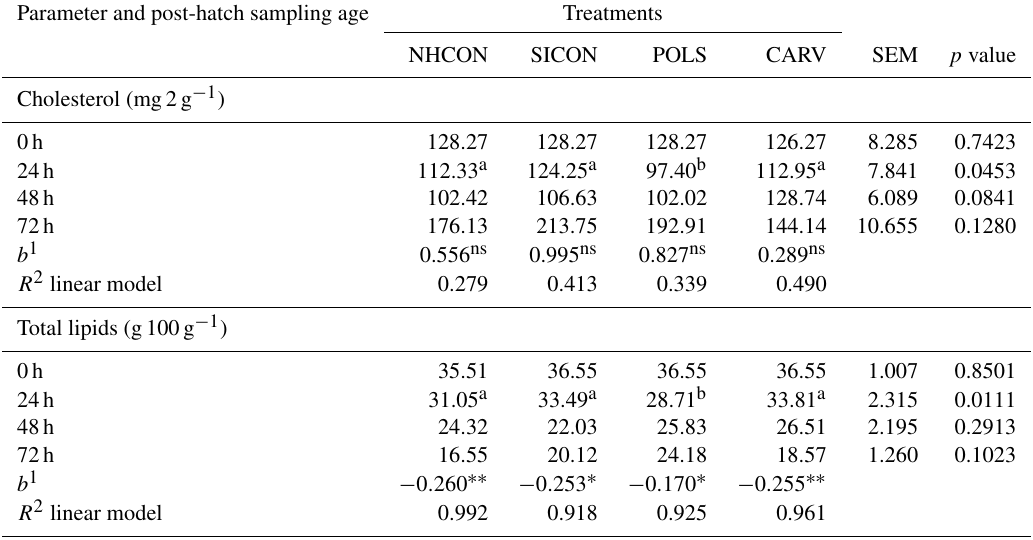
Table 1. Total cholesterol and total lipids concentration in yolk sac in the chicks subjected to experimental treatments, namely non-handled control (NHCON), sham injection control (SICON), polysorbate-80 injection (POLS), and carvacrol injection (CARV), in post-hatch sam- pling